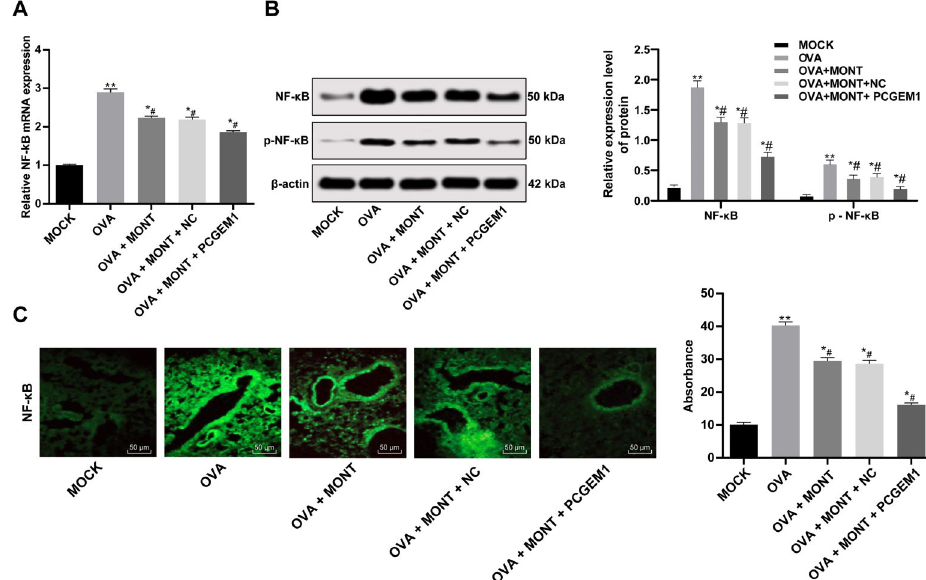
Figure 5. Upregulation of prostate cancer gene expression marker 1 (PCGEM1) combined with montelukast sodium reduced the NF- k B signaling in the ovalbumin (OVA)-sensitized asthmatic mice treated with montelukast sodium (MONT) and PCGEM1 mimic, and normal control (MOCK). A , RT-qPCR determination of NF- k B mRNA expression in the lung tissues. B , Western blot assay of NF- k B and p-NF- k B expression in the lung tissues. C , Immuno fl uorescence analysis of NF- k B expression in the lung tissue. Data are reported as means ± SD. *P o 0.05, **P o 0.001 vs the MOCK group; # P o 0.05 vs the OVA group. Data in panel A were analyzed by one-way ANOVA, and data in panels B and C were analyzed by two-way ANOVA, followed by Tukey ’ s multiple comparisons post hoc test. NC: negative